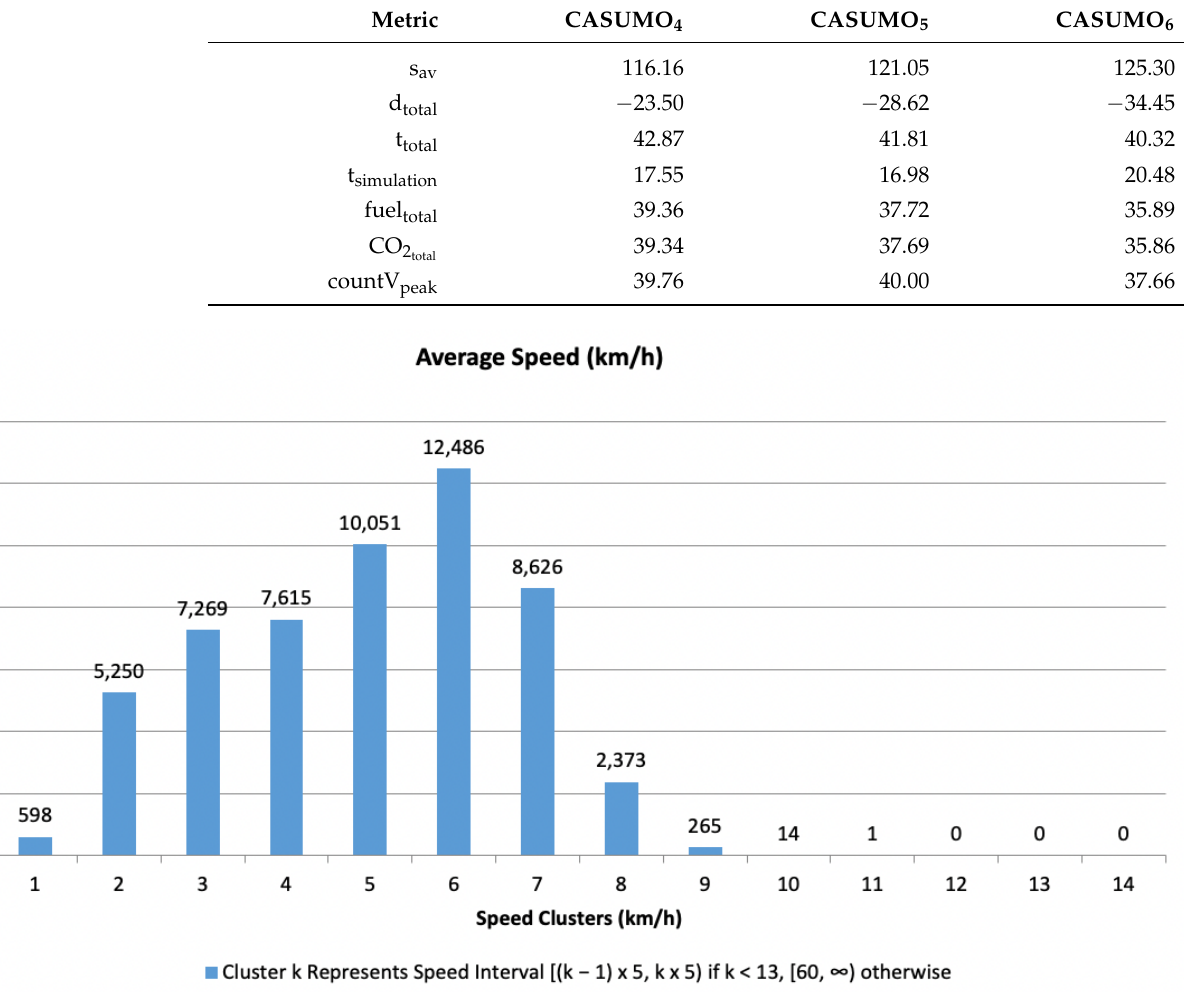
Table 7. Percentage improvement of the proposed solution 50 K+ simulated vehicles in Bucharest.